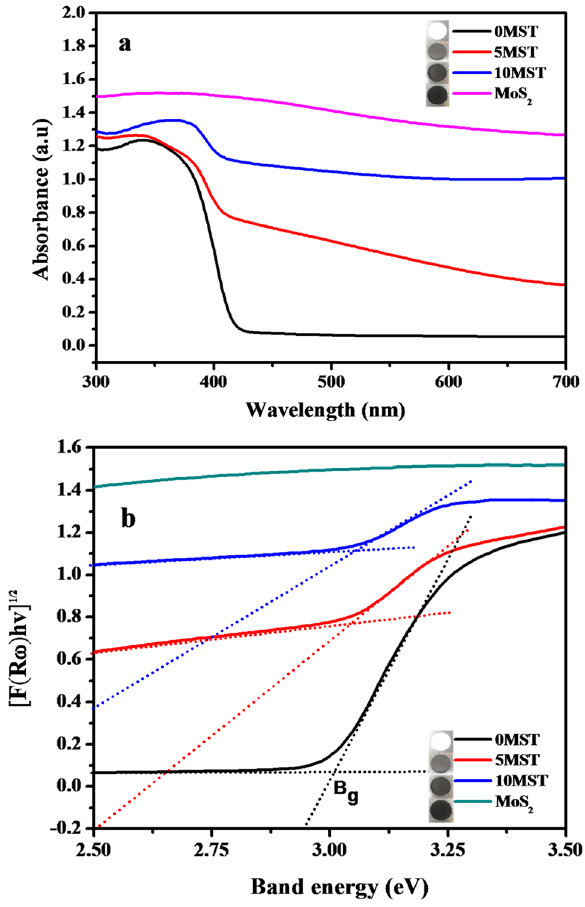
Fig. 7 UV–vis absorption spectra of 0 MST, 5 MST, 10 MST and MoS